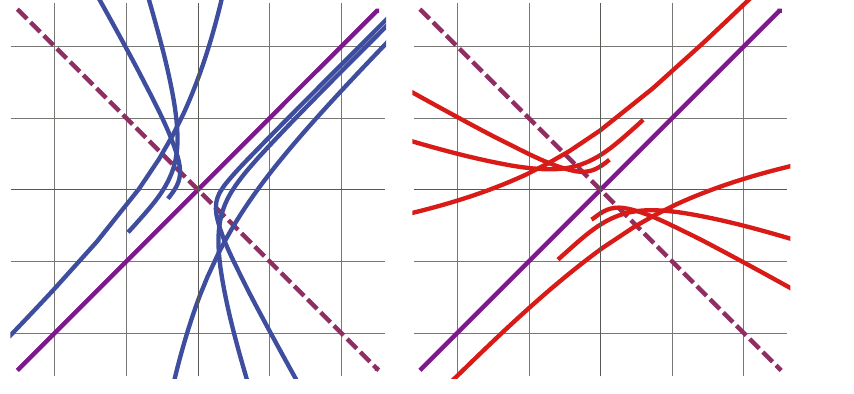
( left ) and timelike curves in (cid:2) 2 with (cid:2) ( ) = v v cv −1